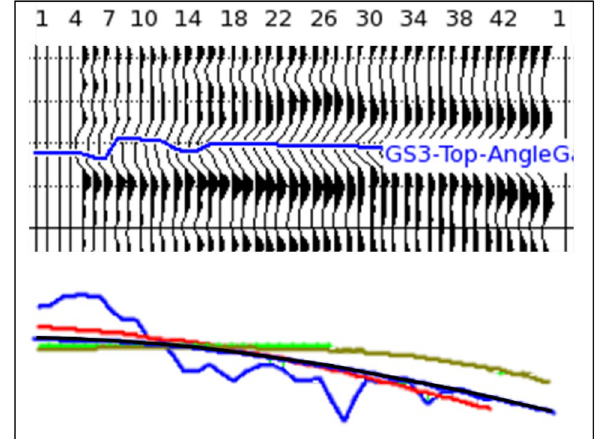
Fig. 8 The blue line is the actual variation of amplitude in seismic gather. The ‘Red’ line is the AVO 2 terms fitting. The ‘Greenish Yel- low’ line is the conventional AVO model using in situ well logs. The black line is the anisotropic AVO model using derived Thomsen’s